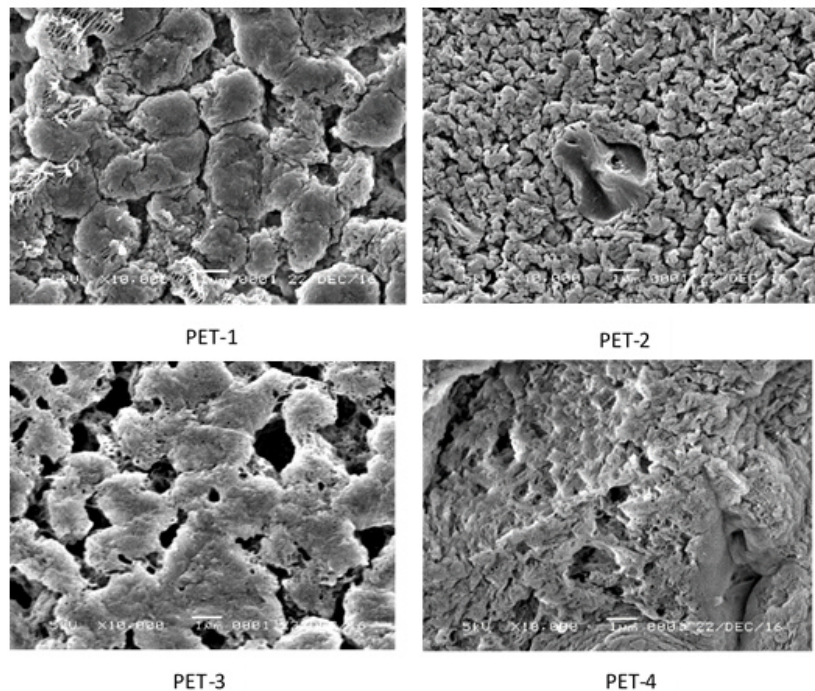
Figure 2. Scanning electron microscopy images of the surface of PET membranes. PET-1, no added PVP or evaporation; PET-2, no added PVP and 7 minutes of evaporation; PET-3, added PVP and no evaporation; added PET-4, PVP and 7 minutes of evaporation.